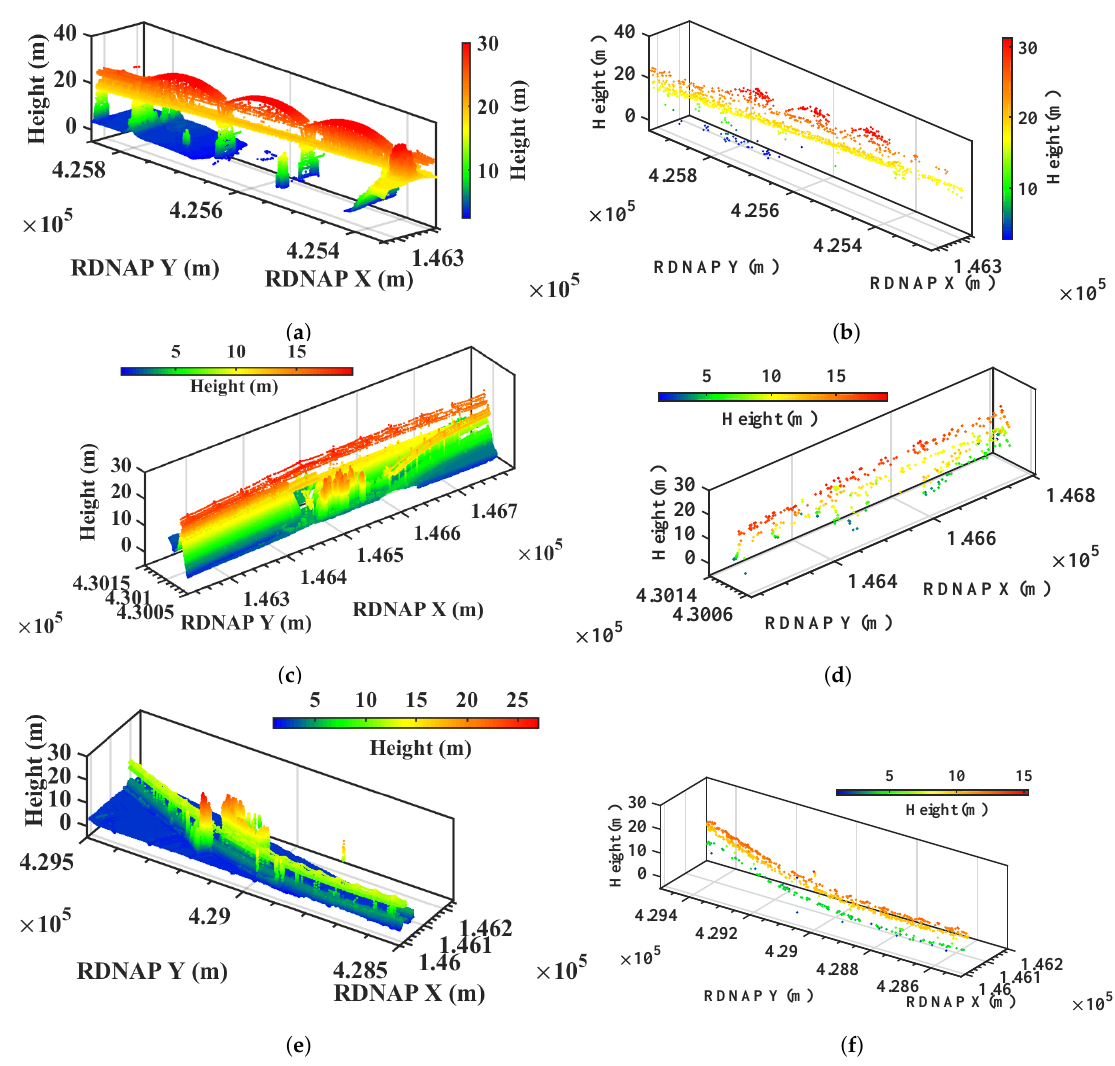
Figure 12. ( a – f ) Comparison of the height model between LiDAR data and radar scatterers. The first column corresponds to the LiDAR data and the second column corresponds to the radar scatterers. Each row corresponds to a selected segment of the